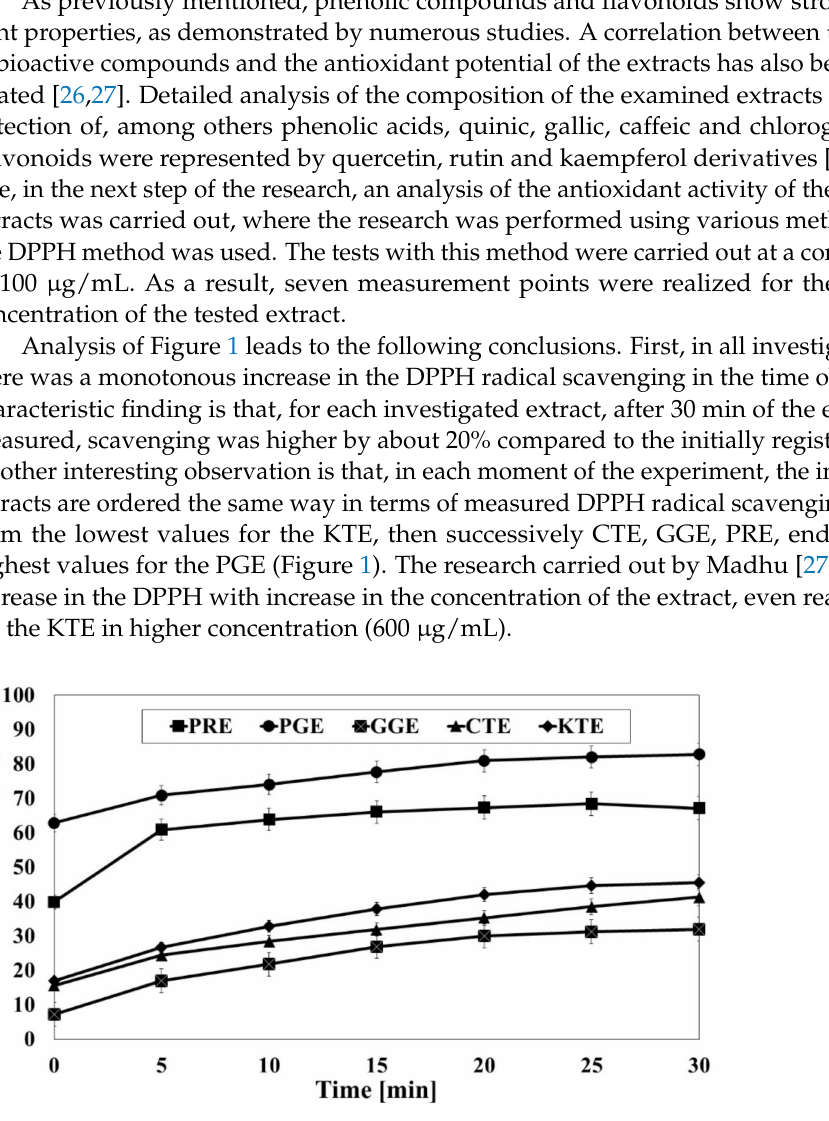
Figure 1. Kinetics of the absorbance changes in DPPH · solutions in the presence of 100 µ g/mL concentrations of water–ethanol extracts PRE ( P. rhoeas L.), PGE ( P. granatum L.), KTE (C. ternatea L.), CTE (C. tinctorius L.), GGE (G. globasa L.). Values are means of three replicate determinations ( n =